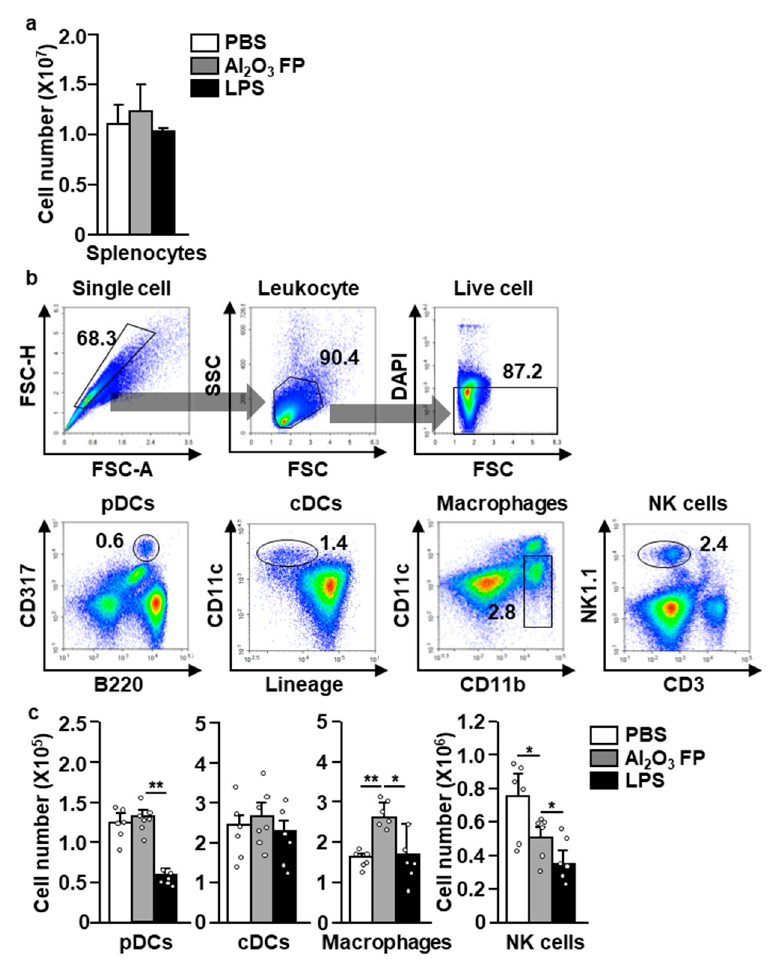
Figure 1. Characteristics of the aluminum oxide fine particles (Al 2 O 3 FPs). ( a ) Transmission electron micrograph, ( b ) size distribution of Al 2 O 3 FPs.